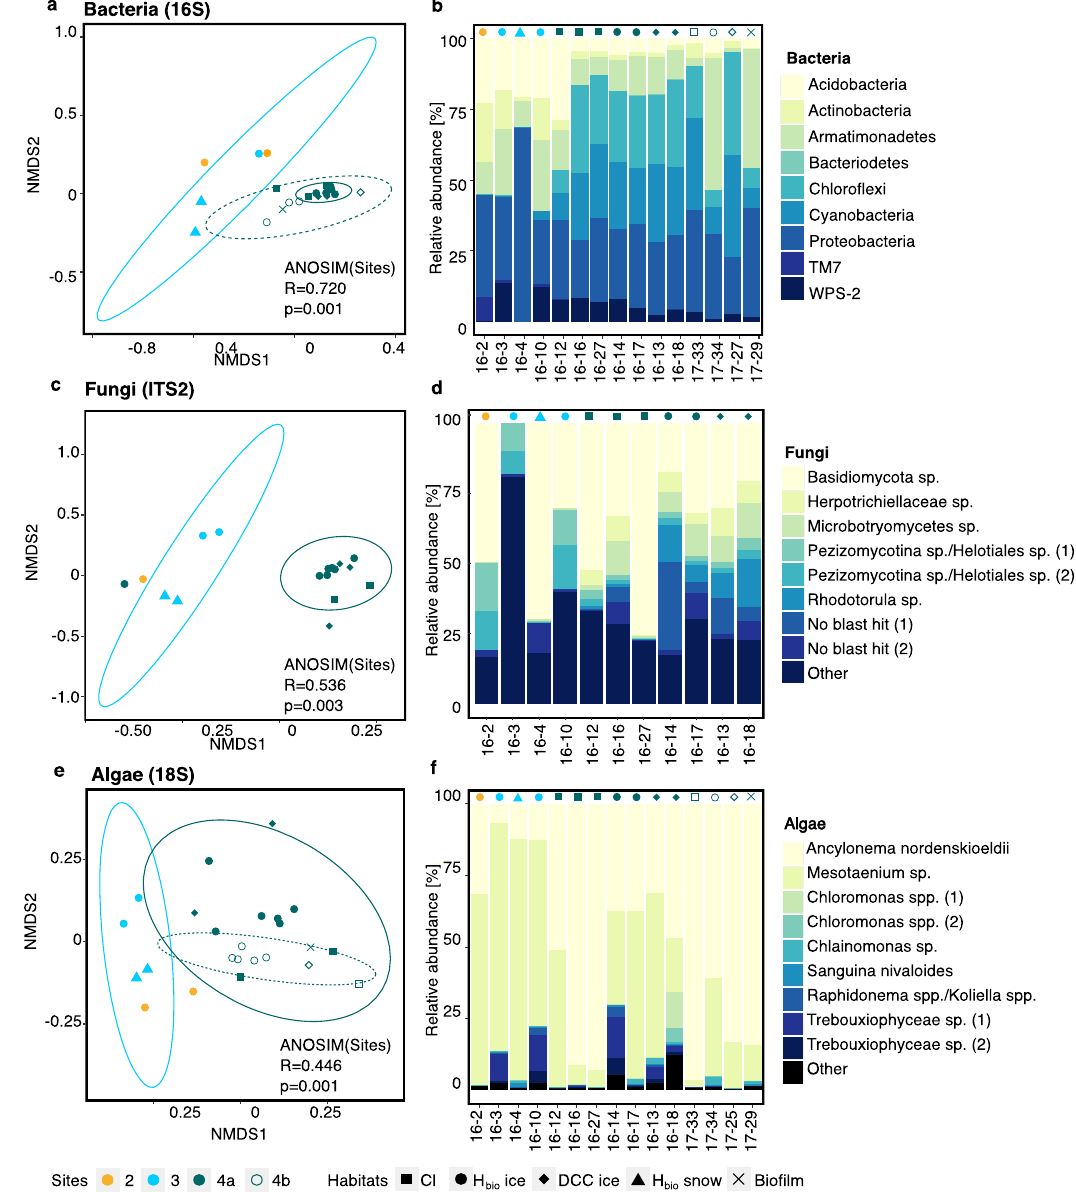
Fig. 4 Composition of bacterial, fungal, and algal communities in surface habitats across the Dark Zone. NMDS plots showing the sample similarities for bacteria ( a ), fungi ( c ), and algae ( e ) and their respective community compositions based on relative abundances ( b , d , f ). Sites are represented by colors and habitats by point shapes. Samples cluster according to sites and dashed lines represent the 95% con fi dence interval. All samples with a suf fi ciently high number of sequences were used for the NMDS plots, whereas representative samples across sites and habitats were selected for the bar charts (details in Supplementary Tables 9 –